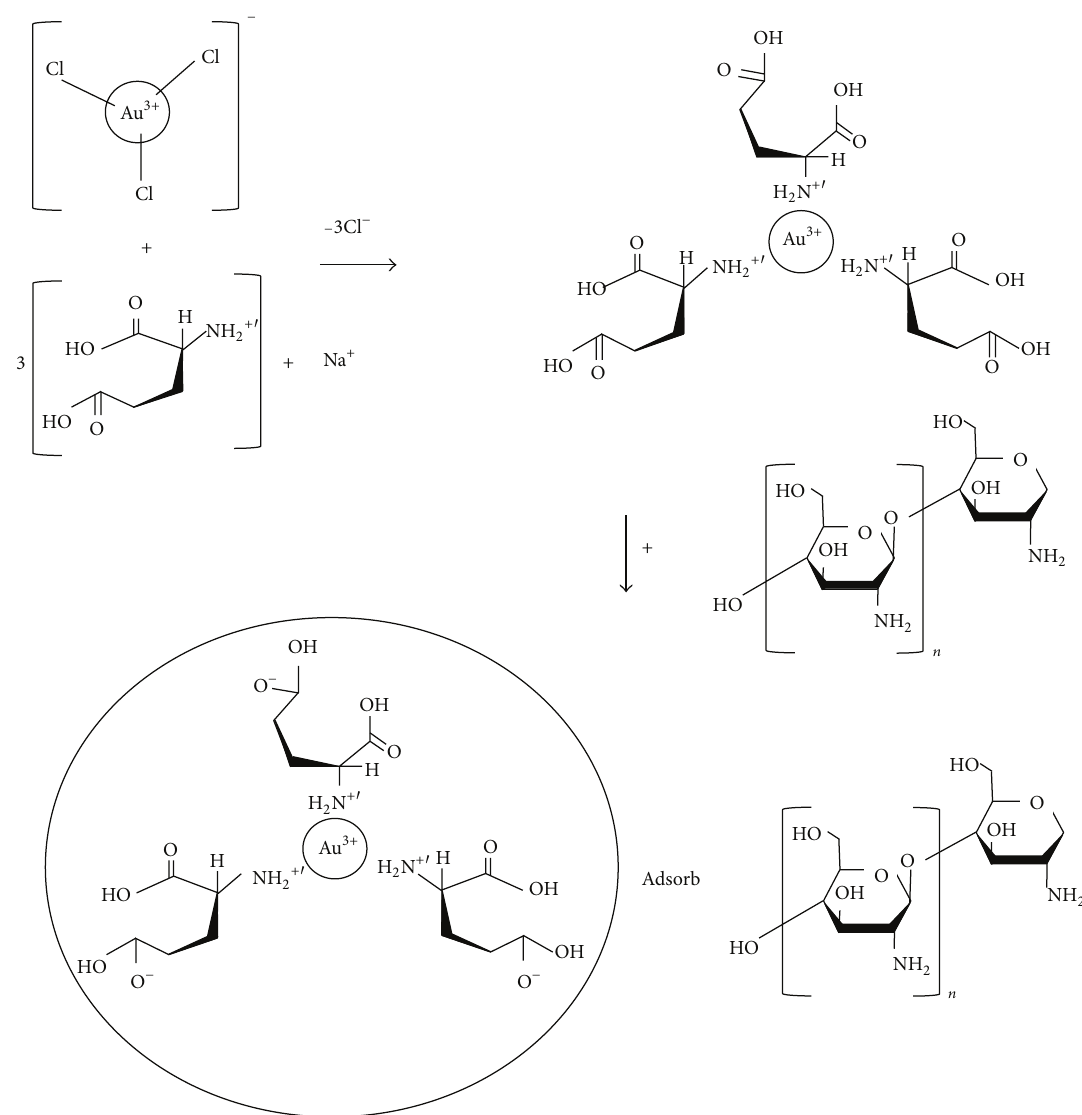
Figure 1: Schematic diagram of gold precursor reduction by MSG and capping the gold particle surfaces with chitosan.